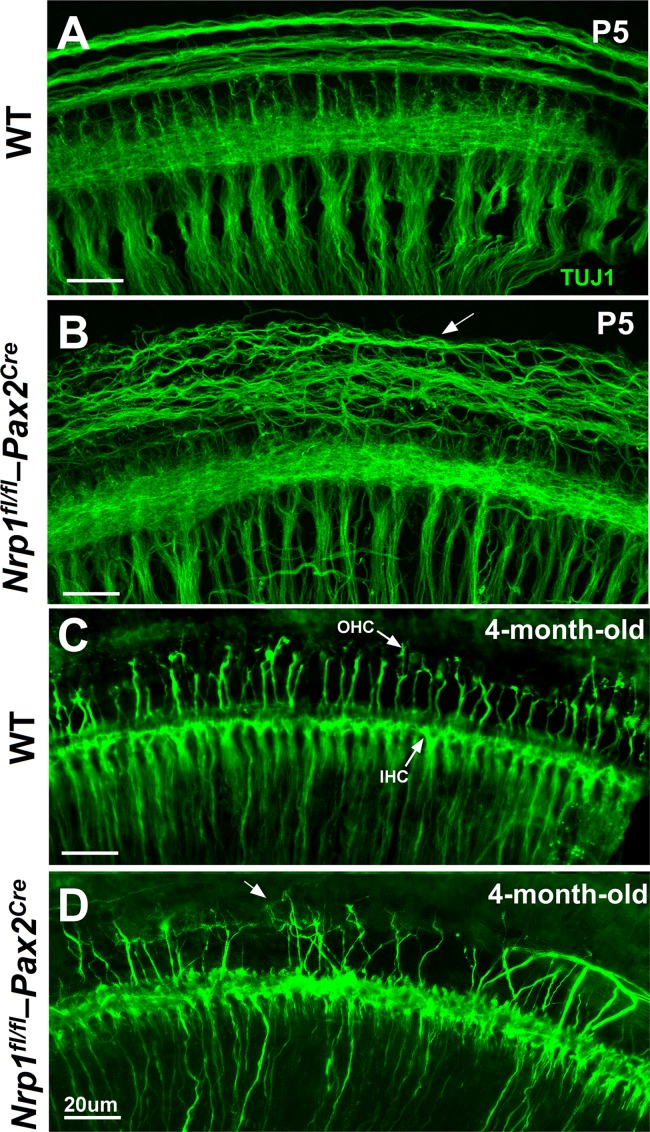
SGN projections in the basal turns of cochleae of WT and Nrp1fl/fl;Pax2Cre mice at P5 and 4-month-old age.Disorganized outer spiral bundles were evident in cochleae of the Nrp1fl/fl;Pax2Cre mice (P5) in the basal turn (n = 3 per group). The arrow shows disorganized outer spiral bundles (B). TUJ1 immunostaining of the SGN fibers extending into the inner and outer hair cell regions in 4-month-old Nrp1fl/fl;Pax2Cre mutants revealed aberrant axons with abnormal innervation of the OHCs. Arrow shows abnormal innervation of the OHCs (D). WT mice did not show aberrant axon migration or innervation. Scale bar = 20 μm.